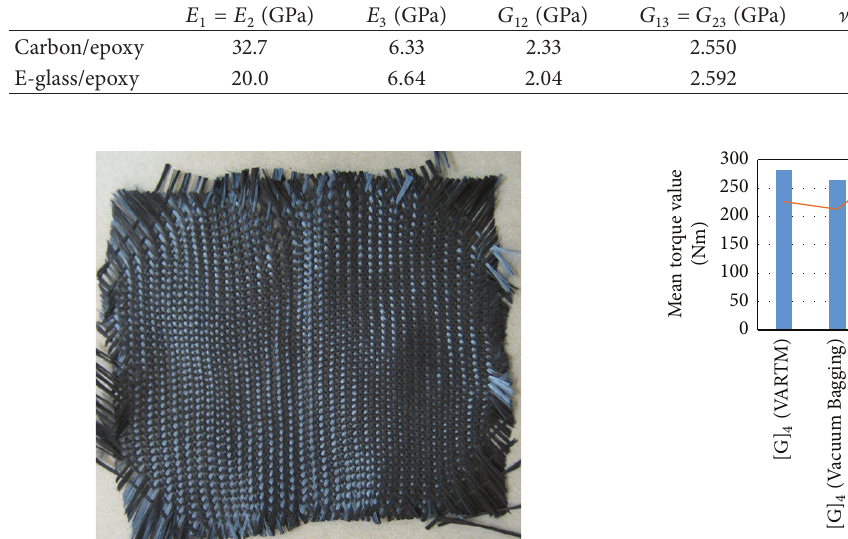
Table 4: Engineering elastic constants, Poisson’s ratios, and density of the carbon and E-glass composites.